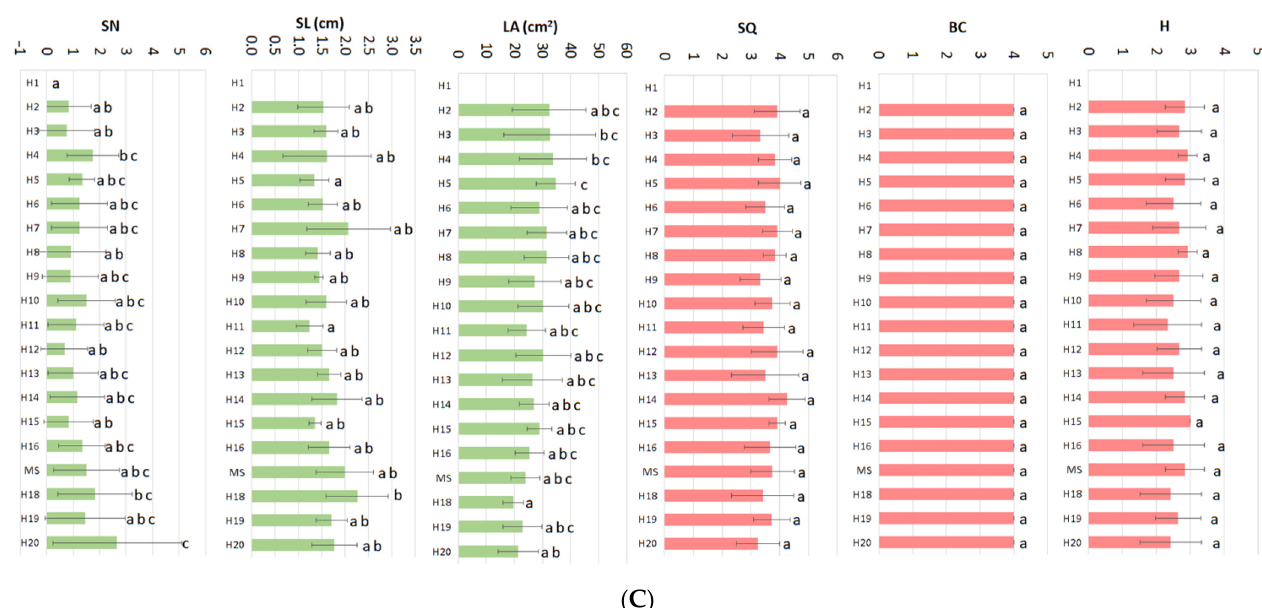
Figure 1. Average results for the different treatments of the mineral nutrients database ( A ), the vitamins database ( B ), and the PGRs database ( C ) for all parameters measured ( SN: shoot length, SL: shoot length, LA: leaf area, SQ: shoot quality, BC: basal callus, H: hyperhydricity ). Green graphs indicate statistically significant differences among the treatments, red graphs are the opposite. Different letters indicate statistically significant differences ( p < 0.05).